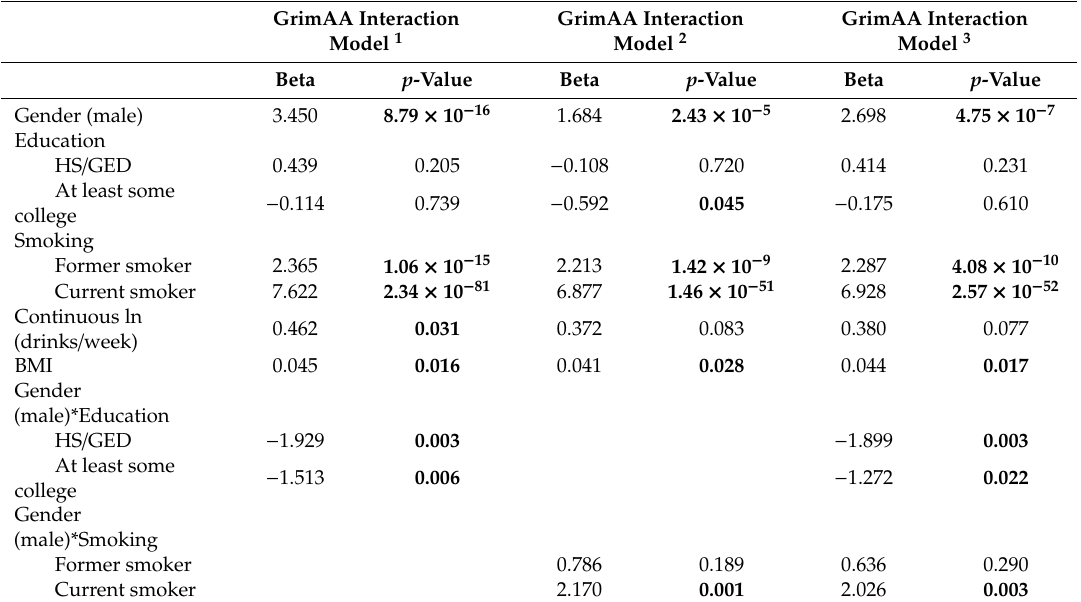
Table 3. Interactions between lifestyle risk factors and gender on GrimAA (Model 3).